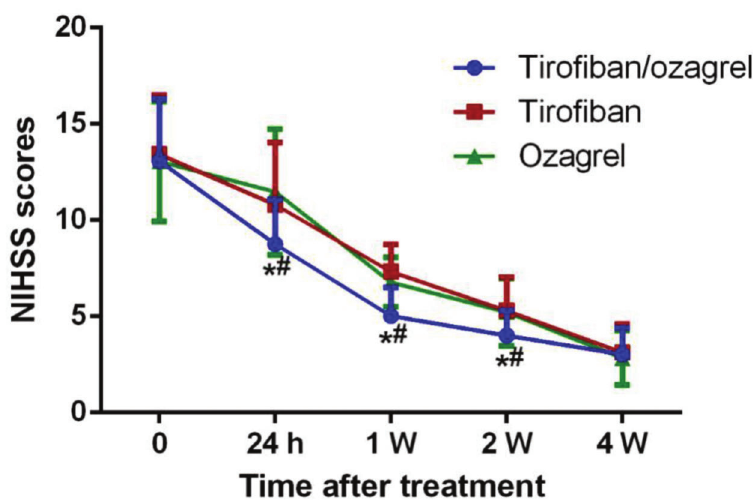
Figure 1 - NIHSS scores of the patients from the different groups. * p o 0.05 versus the Tirofiban group; # p o 0.05 versus the ozagrel group. Table 3 - The BI and mRS values and the incidence of intercranial hemorrhage in each group.